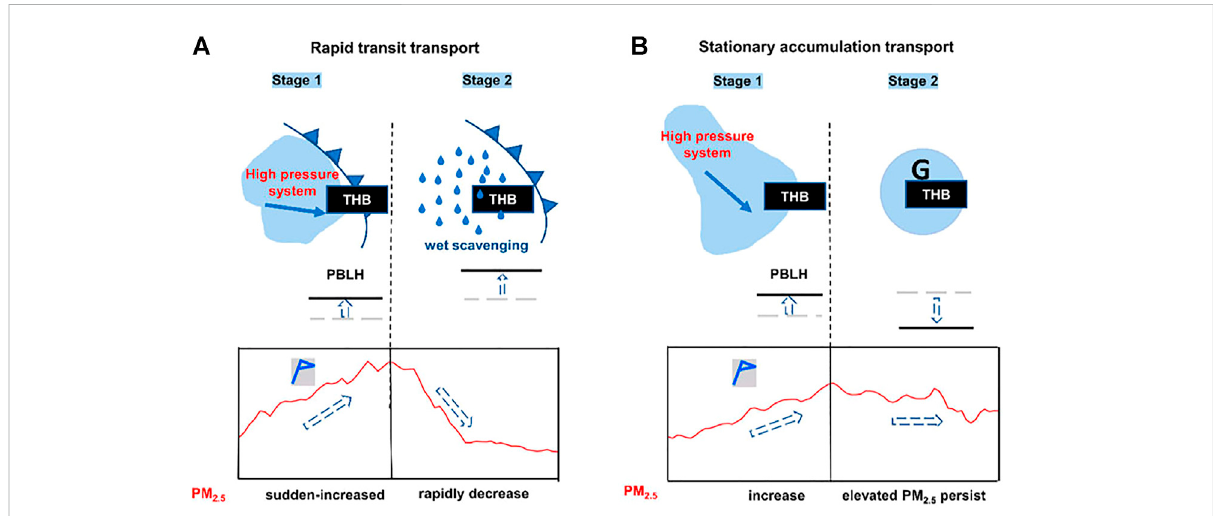
FIGURE 1 Diagramofmeteorologicalmechanism onregionalPM 2.5 transportwiththetypicalpatternsof (A) rapidtransittransport(RTT)and (B) stationary accumulation transport (SAT) driving the PM 2.5 concentration changes (bottom line graphs) for heavy air pollution over the Twain-Hu Basin (THB) revealed in this study. Adapted from Wang et